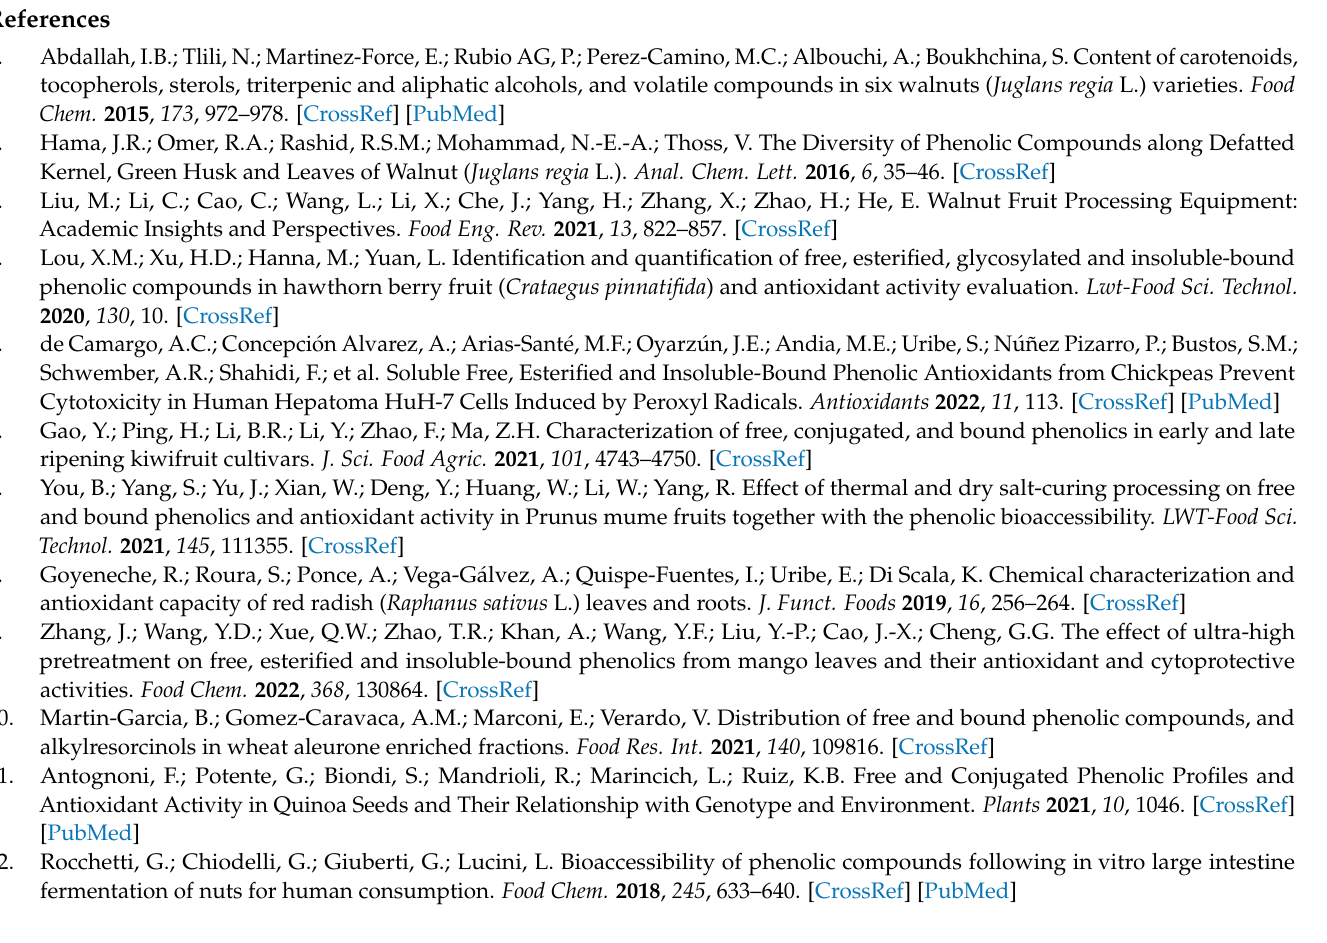
Figure S2: Typical chromatograms obtained at negative (A) and positive (B) MS ionization for standards of phenolic compounds; Table S1: Mass spectrometry parameters of 37 phenolic compounds for multiple reactions monitoring